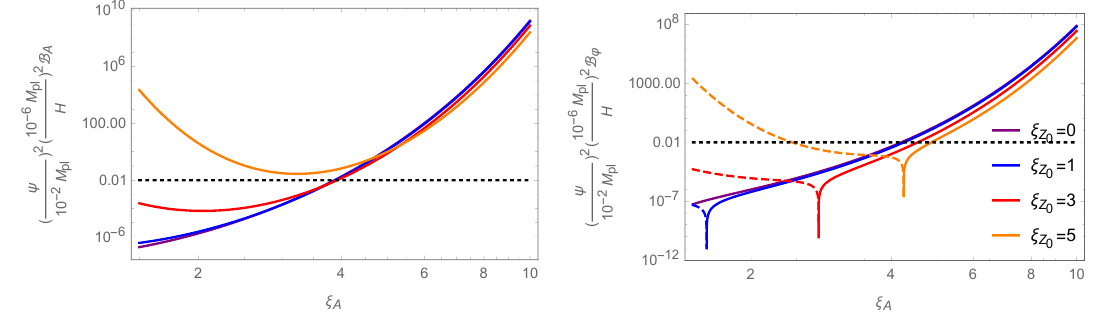
Figure 10 . The dimensionless backreaction terms to the gauge and axion (cid:12)eld equations as a function of (cid:24) A . The dotted black line shows 0 : 01. We show (cid:0) (cid:1) 2 (cid:0) (cid:1) 2 10 2 =M Pl 10 (cid:0) 6 M Pl =H B ’ . The dashed lines show negative values.